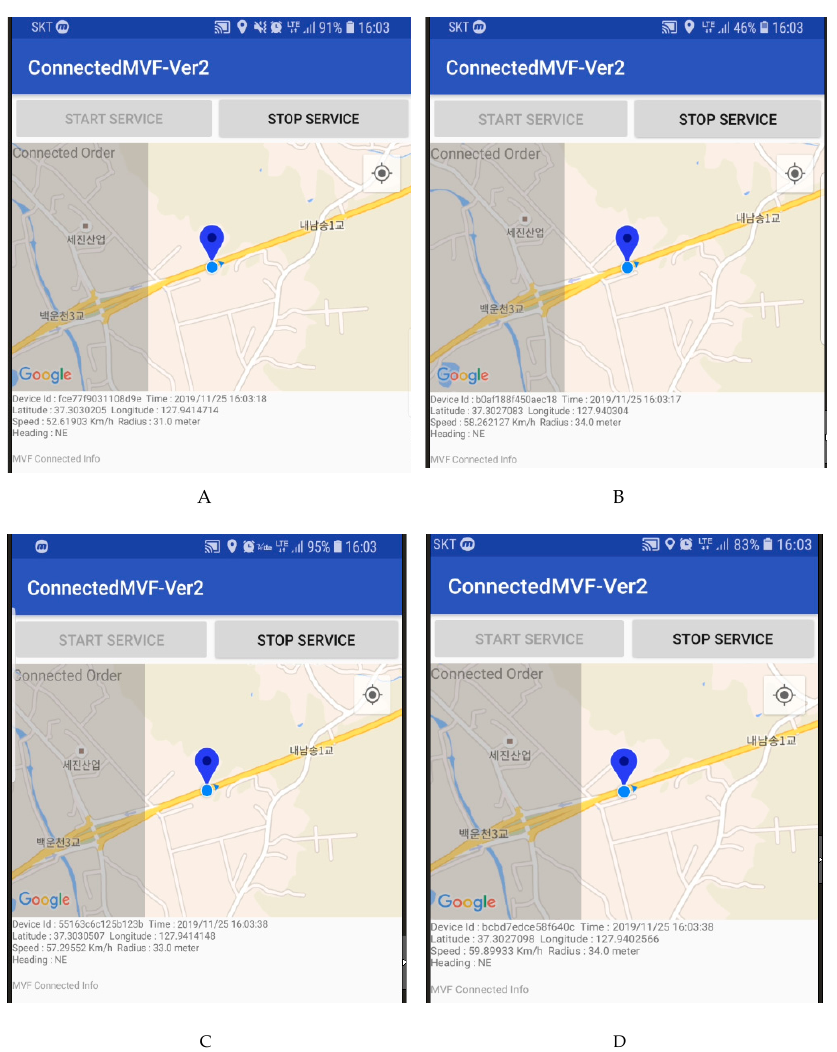
Figure 3. Initial screens of the independent Connected Mobile Virtual Fence (CMVF) clients in the four vehicles.